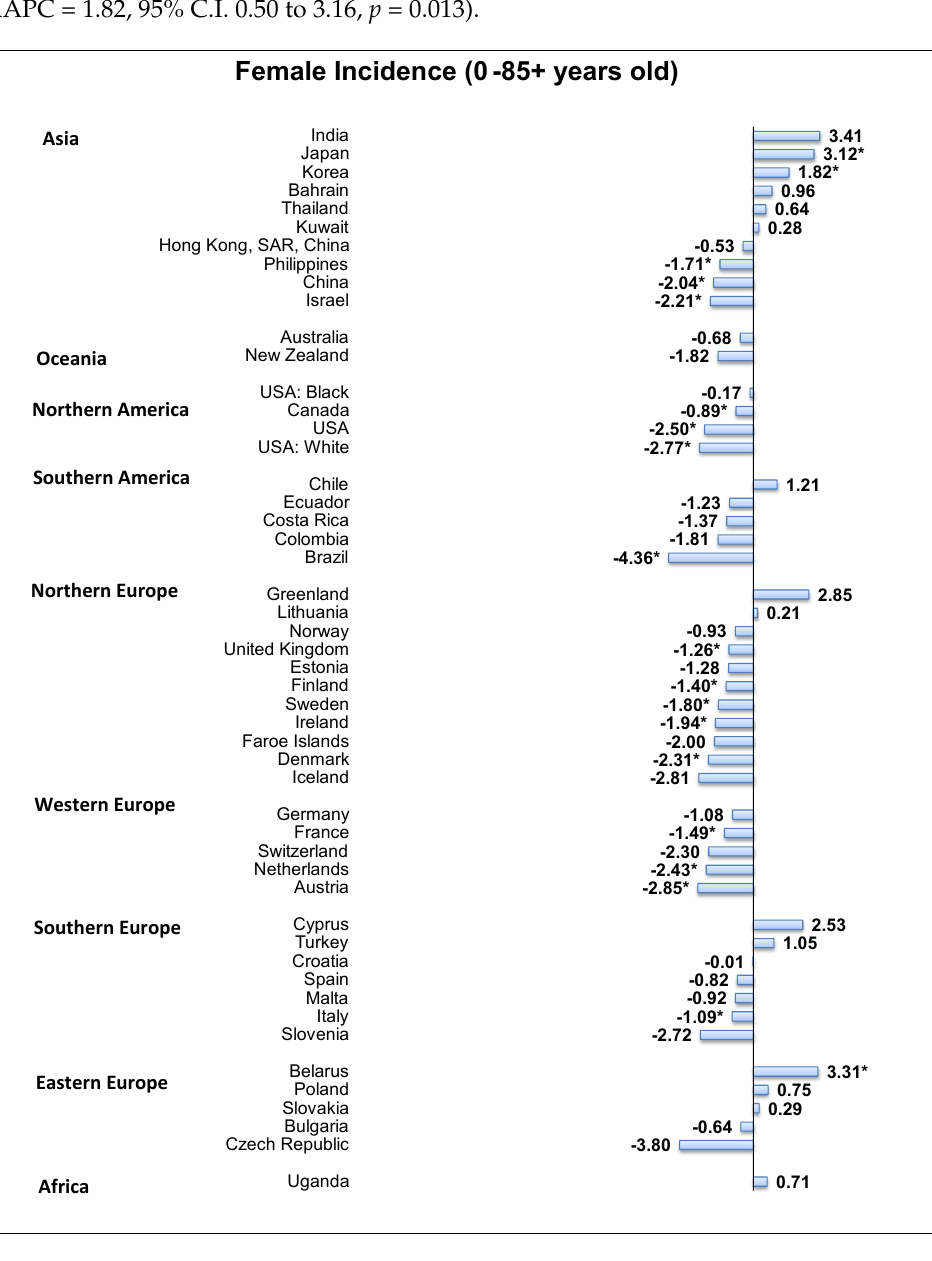
Figure 4. AAPC of incidence of ovarian cancer aged 0–85+. * Statistically